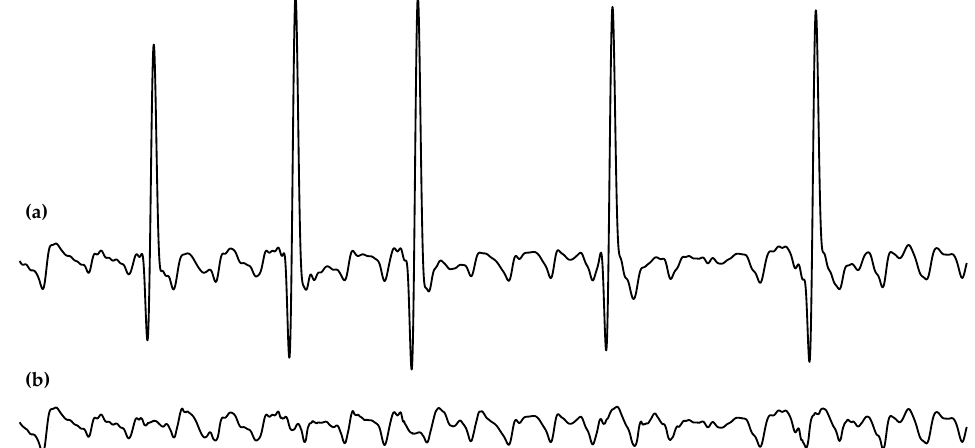
Figure 1. Example of a common ( a ) preprocessed ECG interval and ( b ) its f -waves extracted via a well-known QRST cancellation method